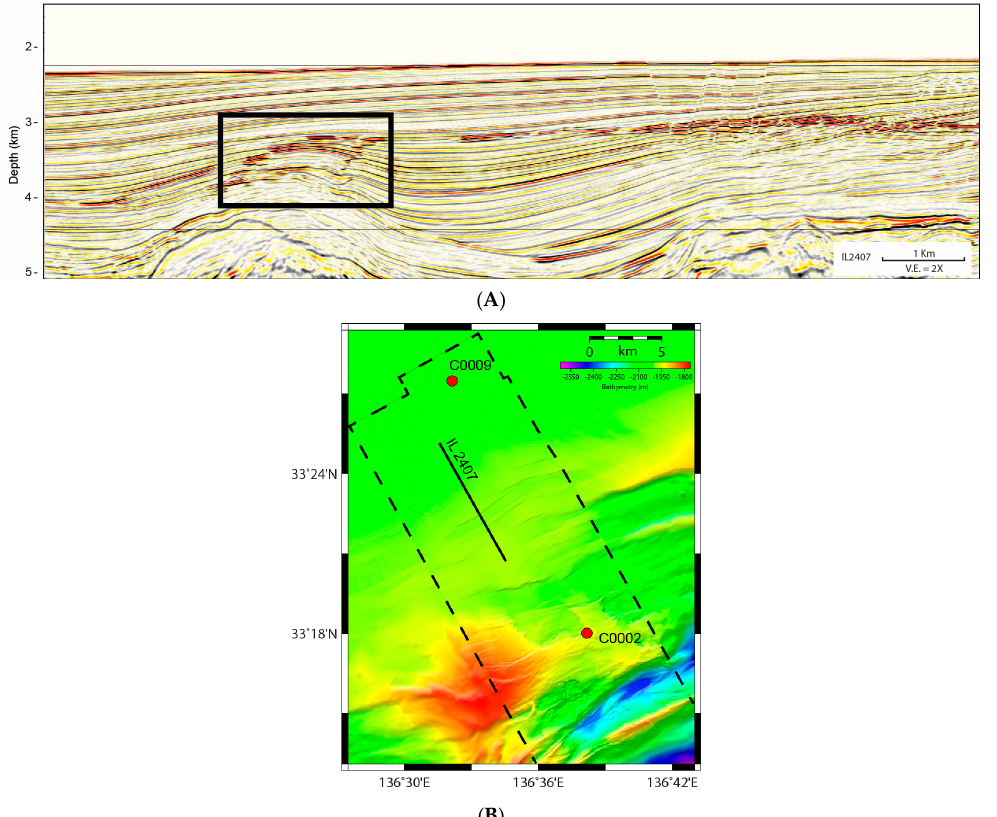
Figure 10. ( A ) Inline 2407. Gas traps along anticlinal hinges above an underlying topographic high in the accretionary prism. Similar HARS along anticlinal hinges have also been observed in the gas hydrate-bearing regions of the Hikurangi [84] and the Makran [85] margins. ( B ) Bathymetric map of the study zone with the extent of IL 2407 shown for